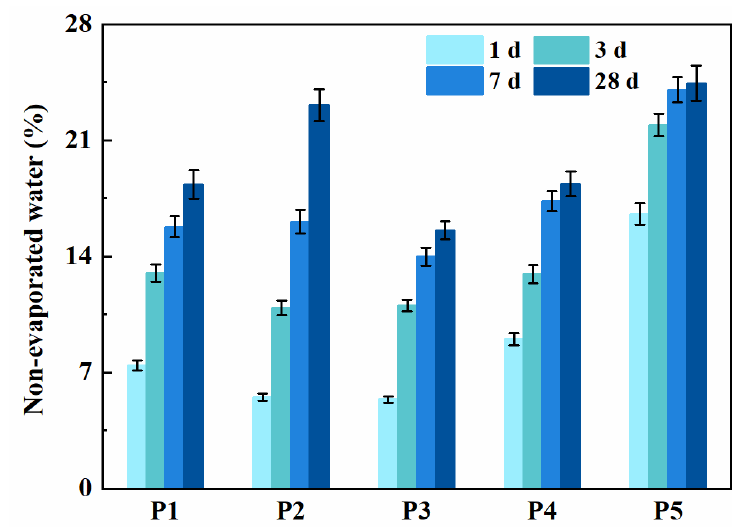
Figure 6. Non-evaporated water of binder pastes at 1, 3, 7 and 28 days. For P2, P3 and P4 specimens, the non-evaporated water contents at 28 days were 23.1%, 15.6% and 18.4%, which were 94.6%, 63.9% and 75.4% of P5. It indicates that paste mixed with slag has a higher non-evaporated water content and higher degree of hydration than that with fly ash. Additionally, the non-evaporated water content of specimen P1 was slightly higher than that of specimen P2 after 3 days. It can be concluded that the varieties of superplasticizer play no prominent chemical contribution to early hydration. However, specimen P2 showed a higher hydration degree at a later